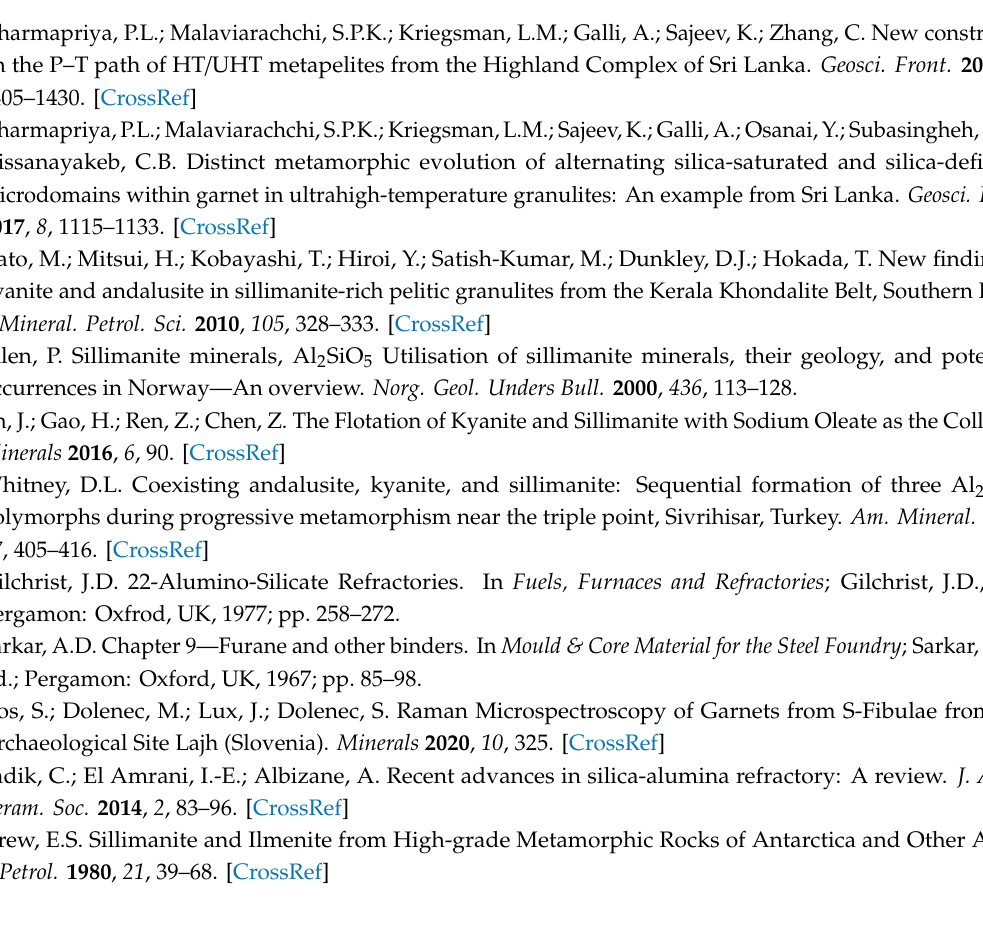
Table S1: Interatomic potential parameters used in the atomistic simulations of Al 2 SiO 5